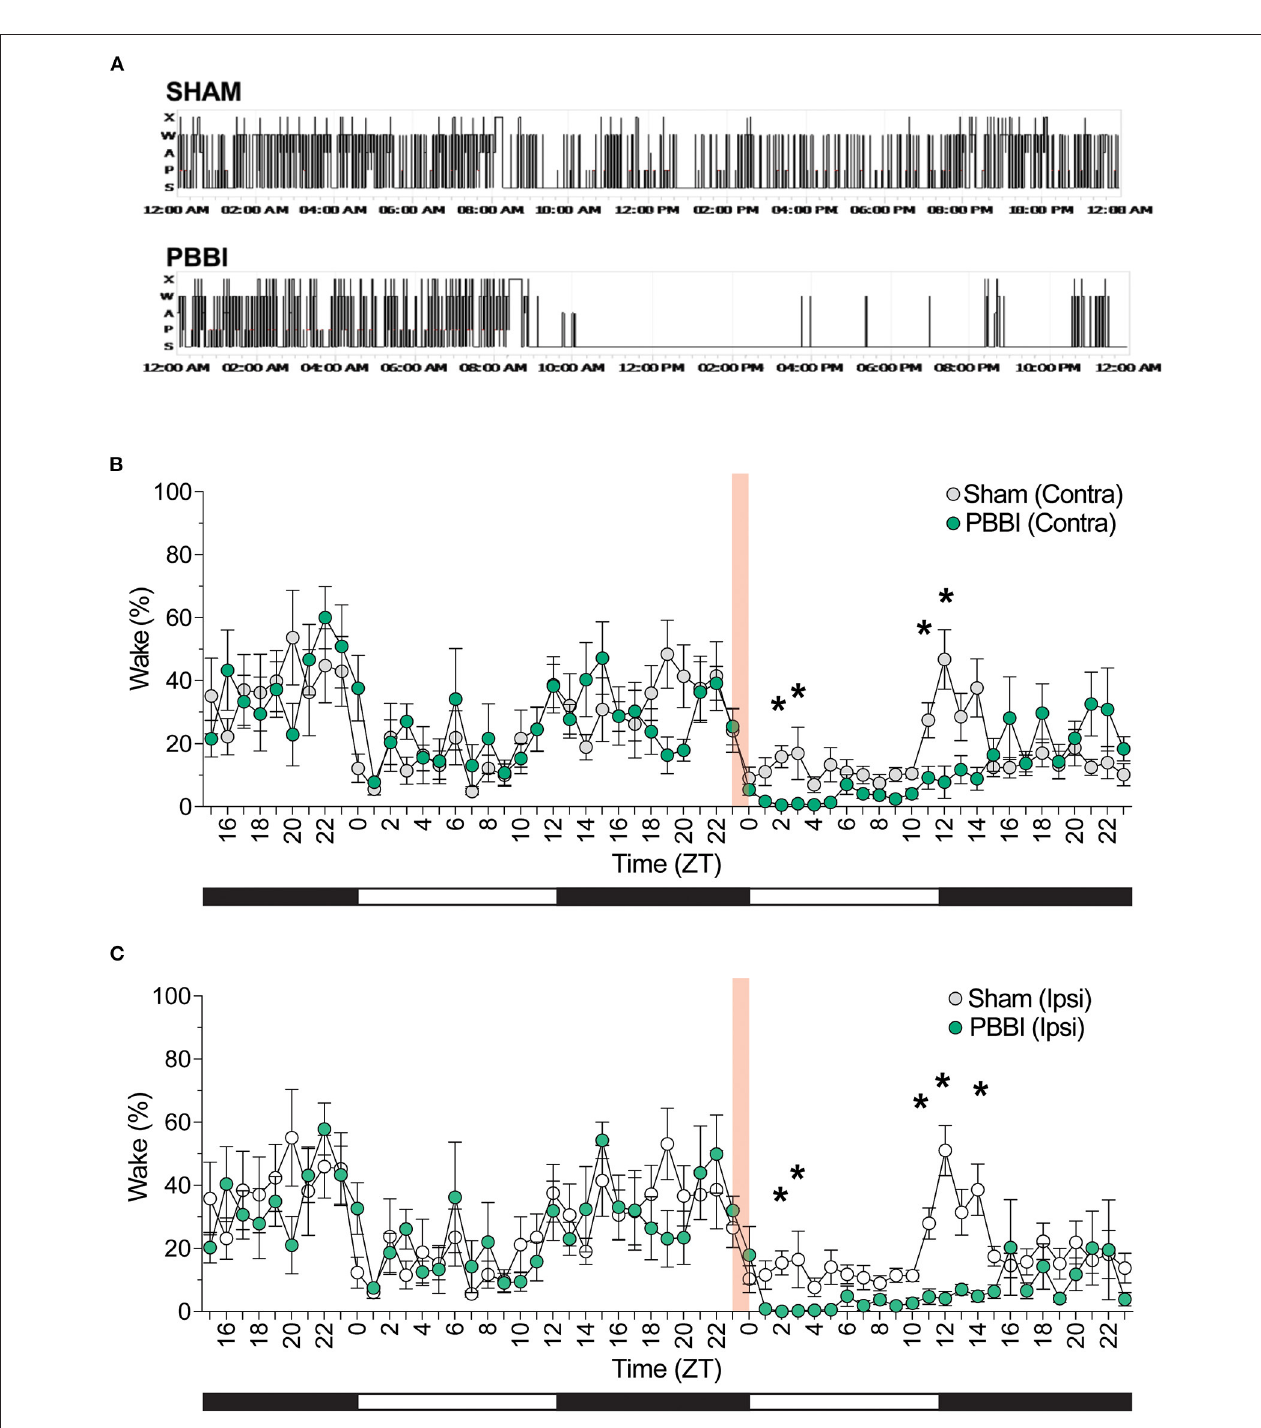
FIGURE 2 | PBBI-induced acute alterations in sleep–wake architecture. (A) Representative hypnograms (24h) of sham and injured rats during baseline through 12h post-injury. (B) Sleep was analyzed for 33h prior to injury and EEG recordings were scored into vigilance states and grouped in 1h bins showing for (B) contralateral and (C) ipsilateral hemispheres of injured rats and sham animals. Red shaded block denotes time of injury. Shaded and unshaded bars indicate dark and light periods of activity. All data are depicted as the mean ± SEM. Comparison between PBBI and sham performed by repeated measures two-way ANOVA with Bonferroni post-hoc test. N = 6 PBBI/ 5 sham. Significant changes were more prevalent on the ipsilateral side (* p < 0.05).